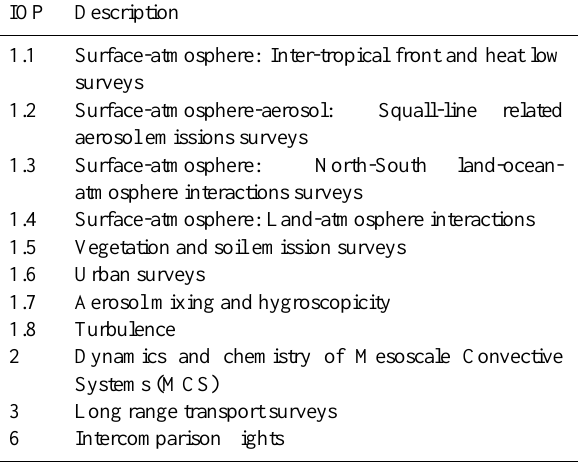
Table 3. Intensive Observational Periods (IOPs). The IOP number- ing system is based on that widely used in the implementation of the AMMA programme. Flights relating to the IOPs listed were flown during the campaigns when the aircraft were fitted with instrumen- tation for chemical and aerosol